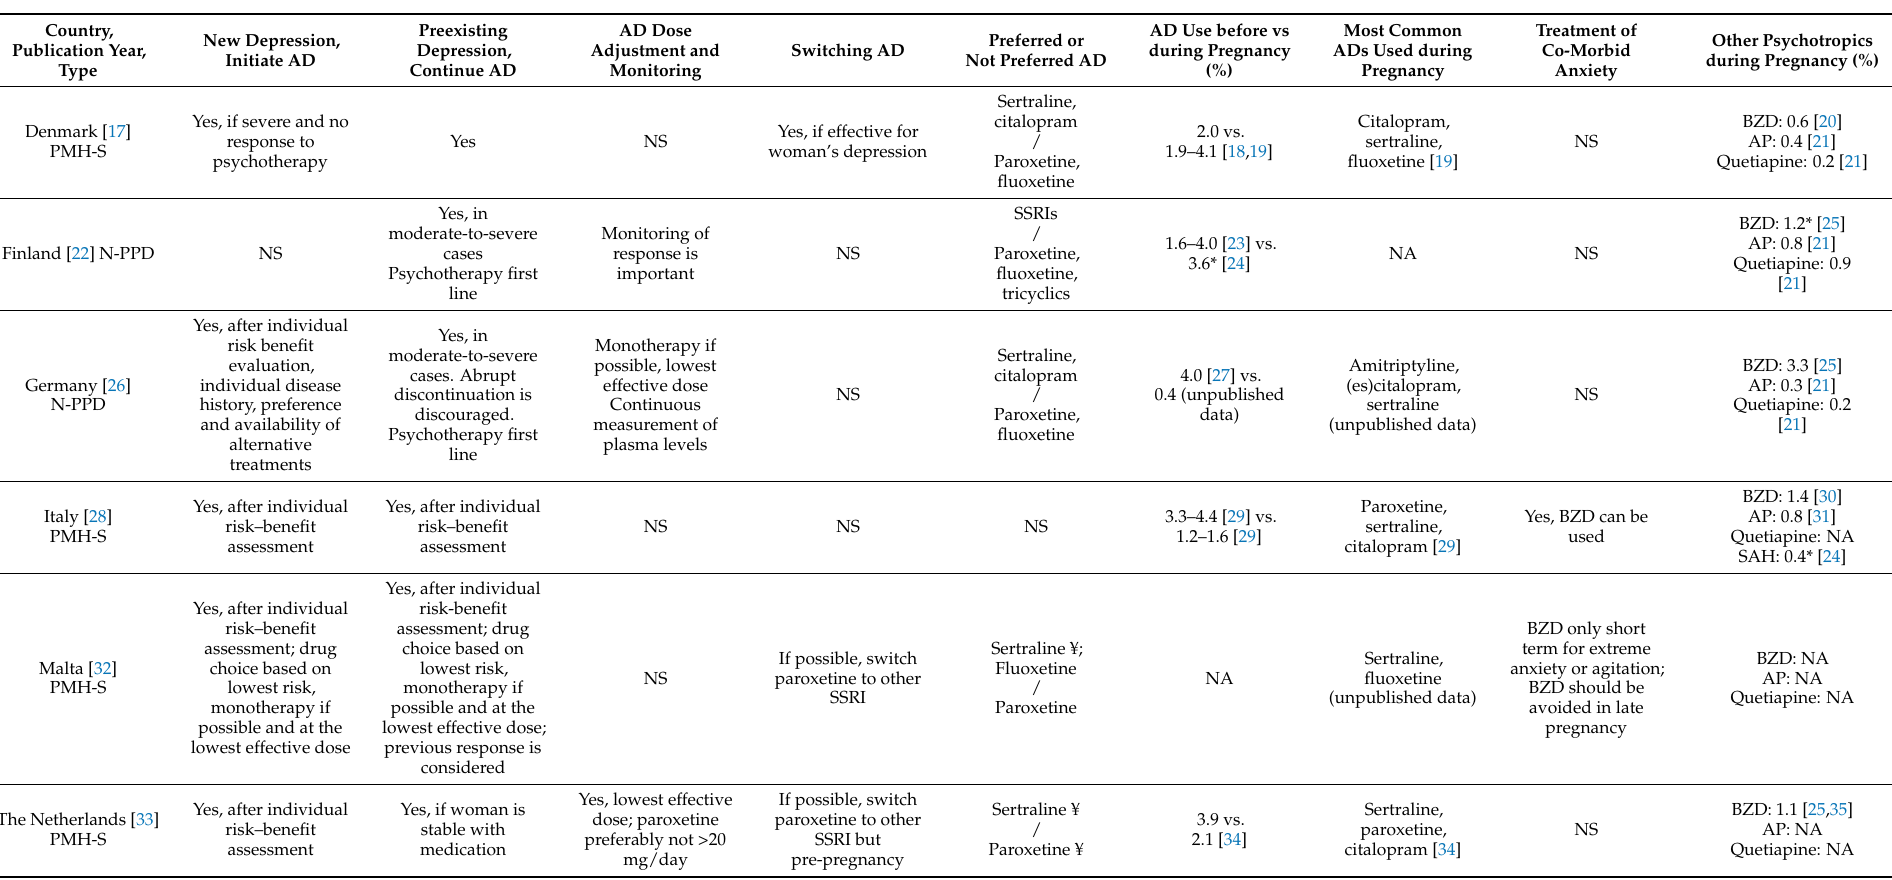
Table 1. Overview of recommendations in the CPGs about antidepressant treatment in women with antenatal depression, with prevalence estimates of antidepressant and other psychotropic medication use in the